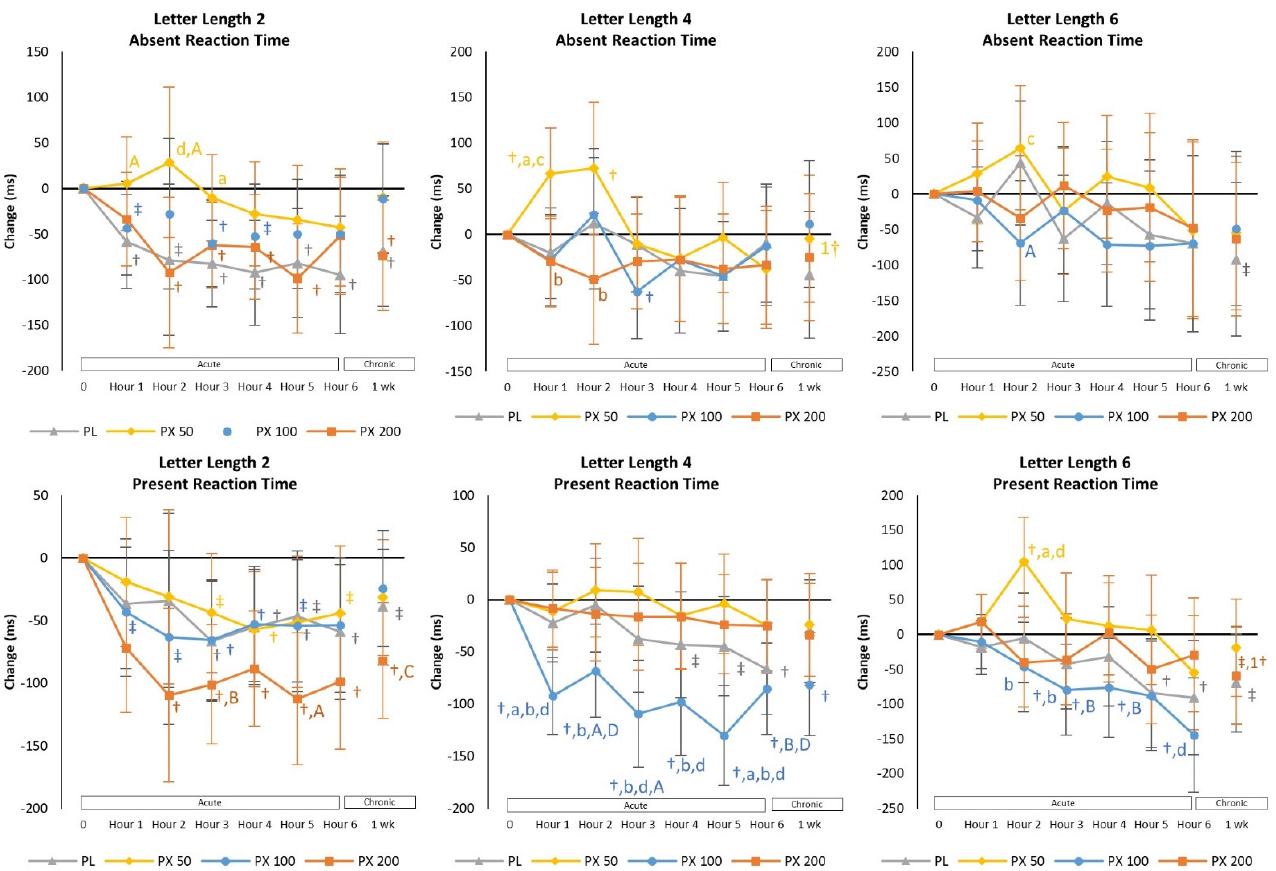
Figure 5. Sternberg Task Test mean ( ± 95% Confidence Intervals) changes in Absent and Present Reaction Times. † = p < 0.05 (‡ = p > 0.05 to p < 0.10) from baseline. 1† = p < 0.05 from Day 1–1 h value. Treatment differences are denoted as from PLA: a = p < 0.05 (A = p > 0.05 to p < 0.10); PXN 50: b = p < 0.05 (B = p > 0.05 to p < 0.10); PXN 100: c = p < 0.05 (C = p > 0.05 to p < 0.10); and PXN 200: d = p < 0.05 (D = p > 0.05 to p <